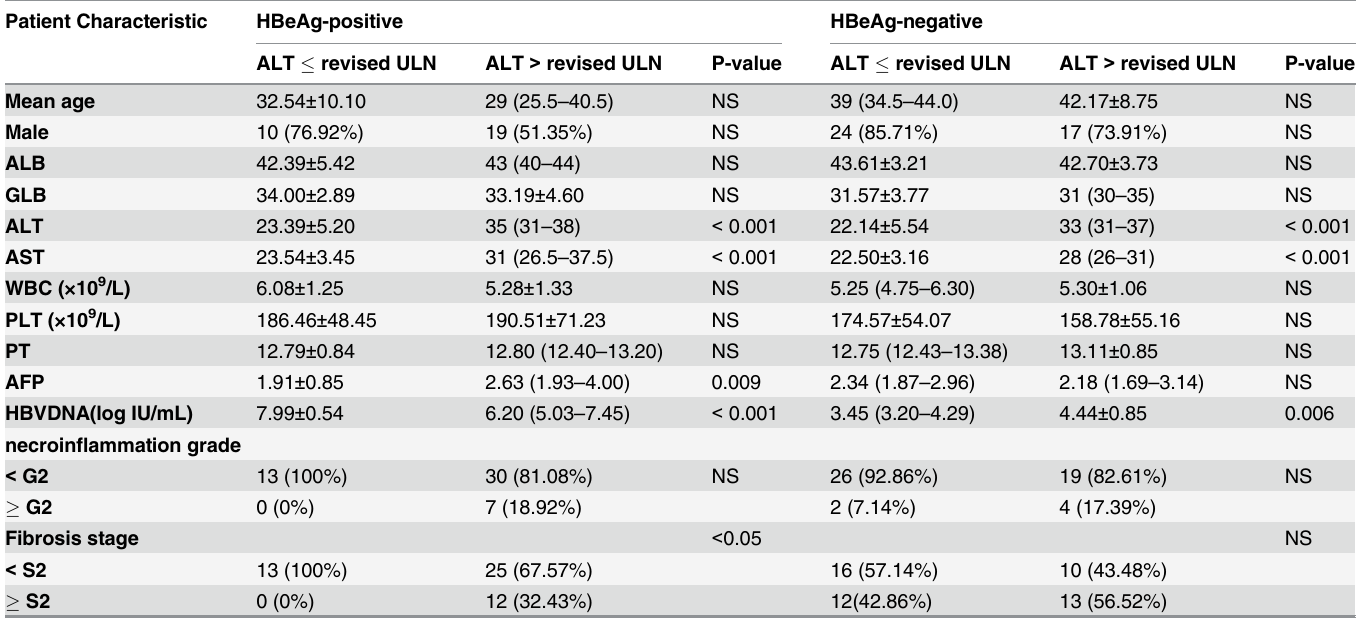
Table 2. Characteristics of CHB patients with PNALT analyzed using revised ULN (ALT of 30 U/L for men and 19 U/L for women). Patient Characteristic